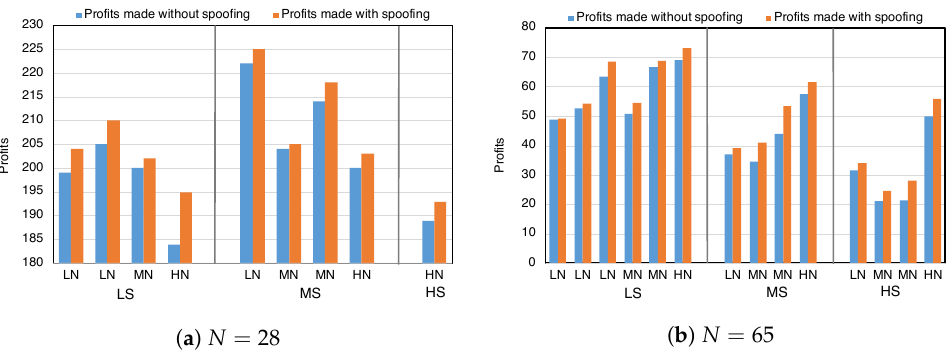
Figure 7. Exploitation profits with and without spoofing against each HBL-and-ZI equilibrium found in Section 5.2. Repetitions of the same market environment represent outcomes of multiple equilibria. Exploitation profits are consistently higher when the spoof action is also